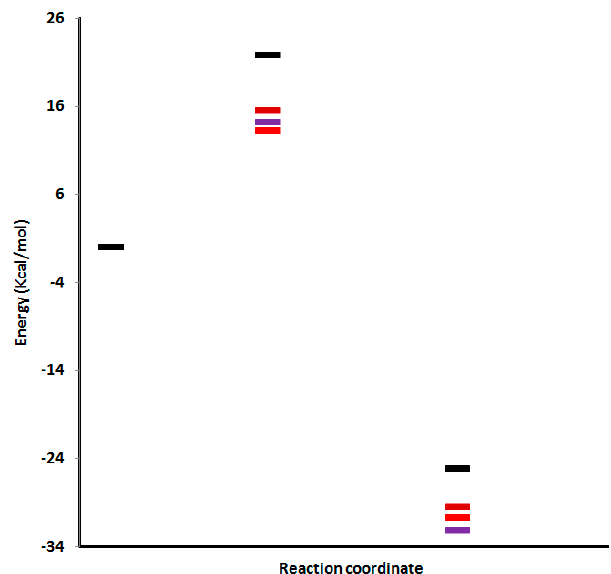
Figure 3. Energy profiles, in kcal/mol for the two pathways of the CA reactions (red; 4 , violet 5 , brown 6 and black 7 ).